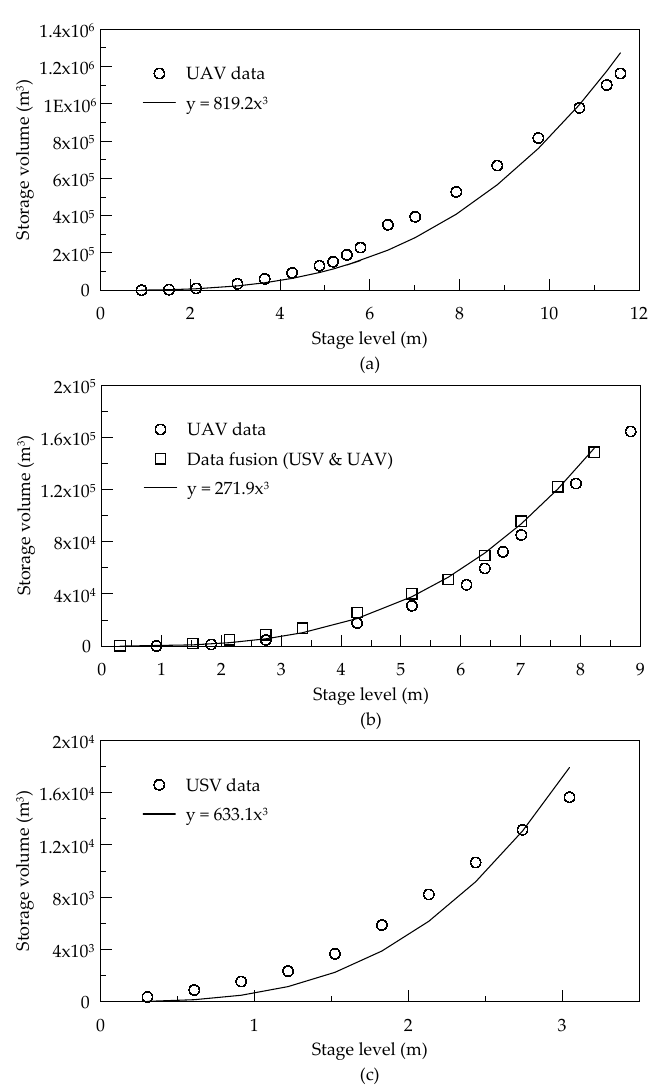
Figure 7. Stage-storage relationships for: ( a ) Hadonahalli tank, ( b ) SM Gollahalli tank, including both UAV only and data fusion results, and ( c ) Nelamangala lake. In Figure ( b ), results from the UAV and USV data fusion approach (represented by squares) at SM Gollahalli tank yielded larger storage volumes compared to the data collected solely by the UAV (represented by circles). This is because tank topography in submerged areas cannot be captured with UAV imagery; supplemental measurements collected by the USV offer a more accurate representation of tank storage